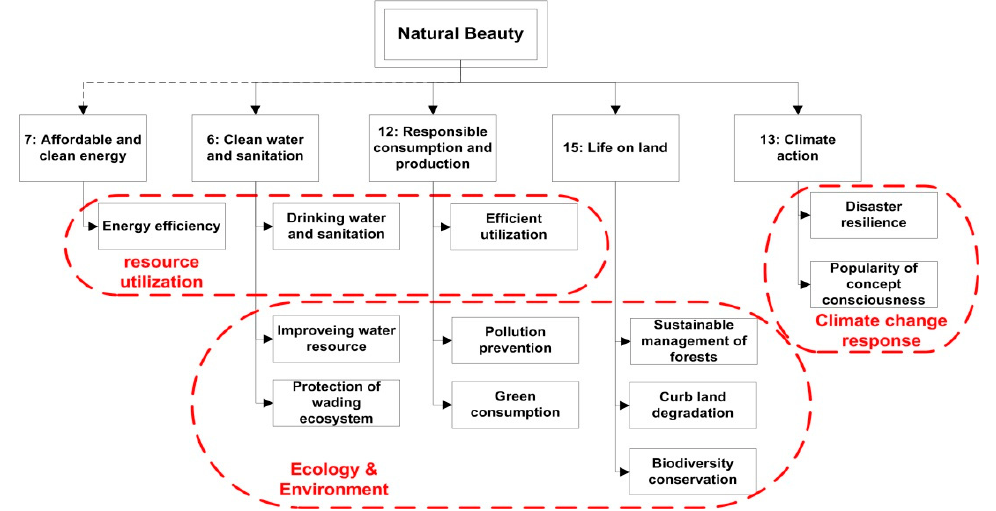
Figure 9. Focused analysis of environmental SDGs cluster in Deqing.